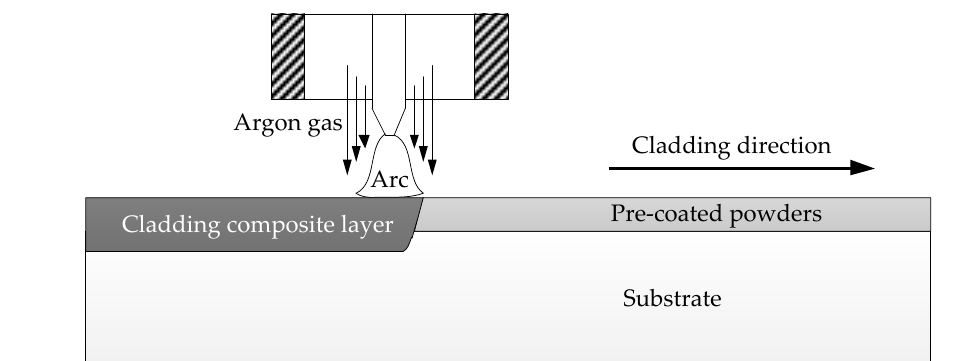
Figure 3. Schematic diagram of the argon-shielded arc cladding process. Table 1. Main parameters of the argon-shielded arc cladding process.